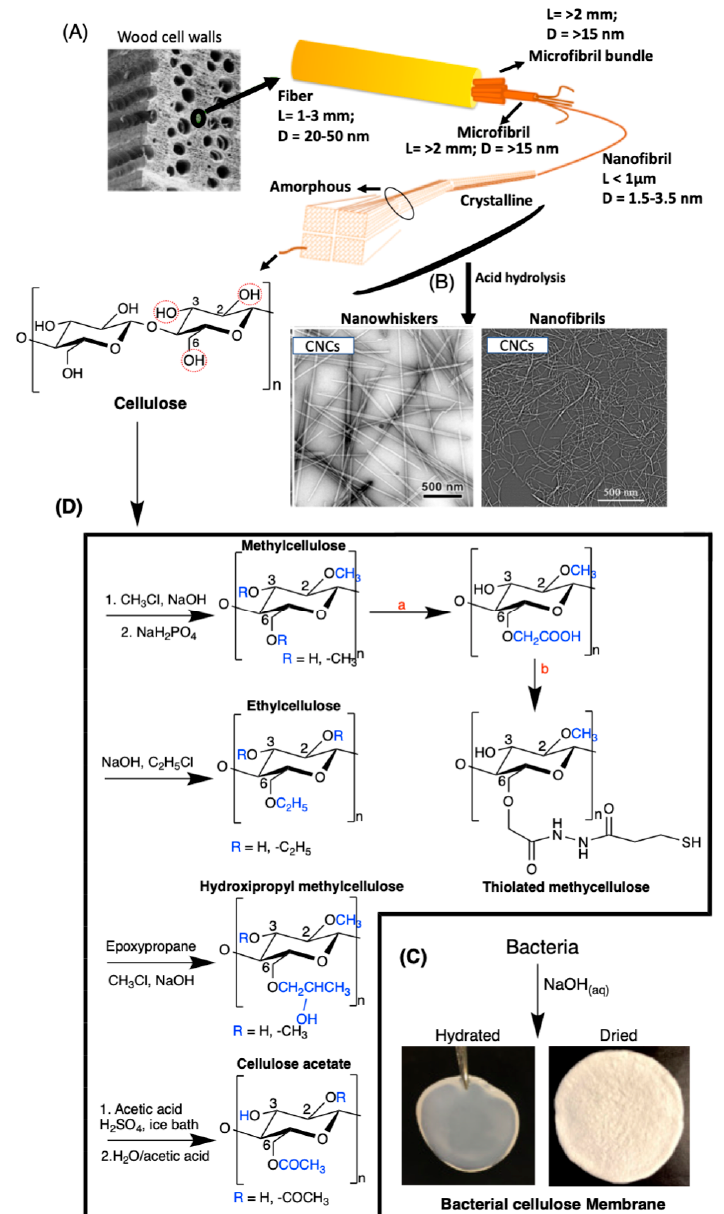
Figure 6. ( A ) Adapted with permission from References [122,123]; Published by Elsevier, 2020 and IntechOpen, 2015, respectively. ( B ) Adapted with permission from [123,124]; published by IntechOpen, 2015 and American Chemical Society, 2017, respectively. ( C ) Adapted with permission from Reference [118]; Published by Elsevier, 2020. ( D ) Adapted with permission from References [125–127]; published by Elsevier, 2019 and 2020 and American Chemical Society, 2012, respectively. Data: a = 3 M bromoacetic acid, 1 M NaOH, 3 h, 4 ◦ C. b (i) 1-ethyl-3-[3-(dimethylamino)propyl]-carbodiimide, 3,3 (cid:48) -dithiobis (propionic dihydrazide), pH 4.5, 2 h, room temperature; (ii) dithiothreitol, pH 8.5, 24 h, room temperature. L = length, D = diameter, CNCs = cellulose